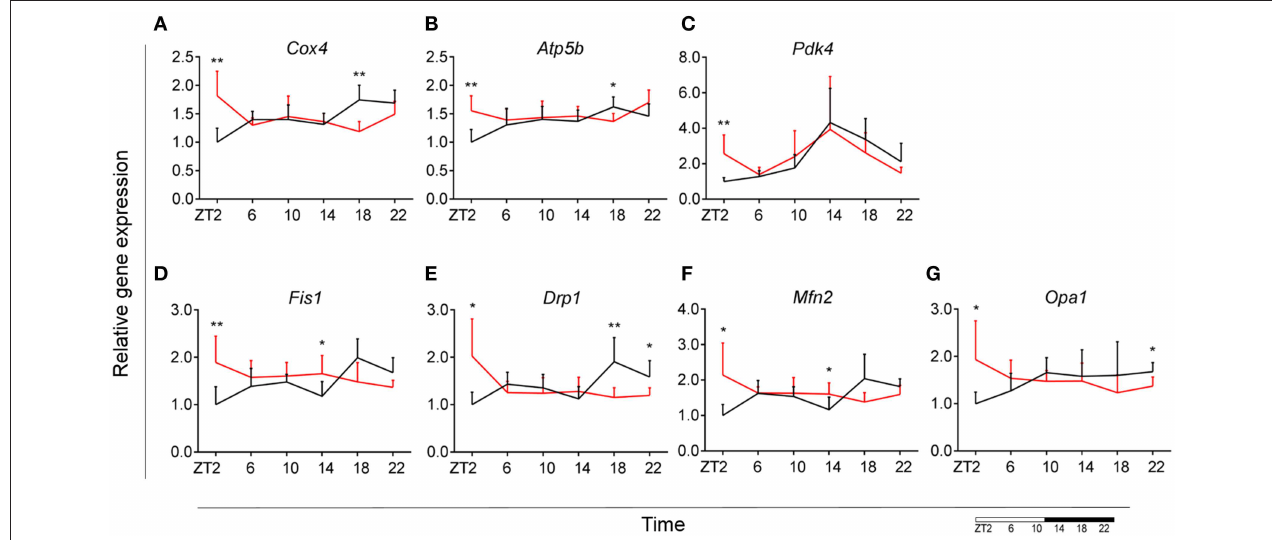
FIGURE 6 | Microglial mitochondria signaling during DIO. Relative gene expression of mitochondria bioenergetics genes Cox4 (A) , Atp5b (B) , and Pdk4 (C) , as well as mitochondria dynamics gene Fis1 (D) , Drp1 (E) , Mfn2 (F) , and Opa1 (G) in HFD-fed rats (red) compared to Chow-fed controls (black) evaluated at six time points, starting at ZT2. Data are presented as means ± SEM. Statistical significance was determined using Two-way ANOVA effect for Interaction , Diet, and Time (ZT); Student t -test is used for diet effect within a separate time point (* p < 0.05; ** p < 0.01). Scale (bottom right) represents light (ZT0-12) and dark (ZT12-24) phase.